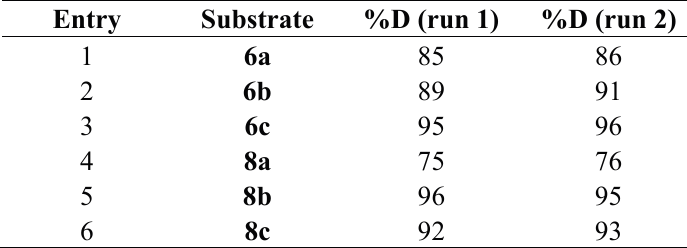
Table 4. Deuteration of Esters 6a – c and 8a – c at 40